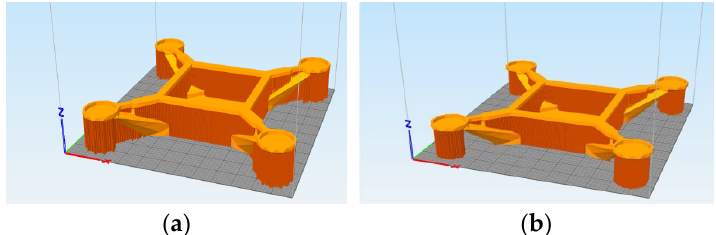
Figure 11. Model sliced with ( a ) 45° overhang angle, ( b ) 46° overhang angle.